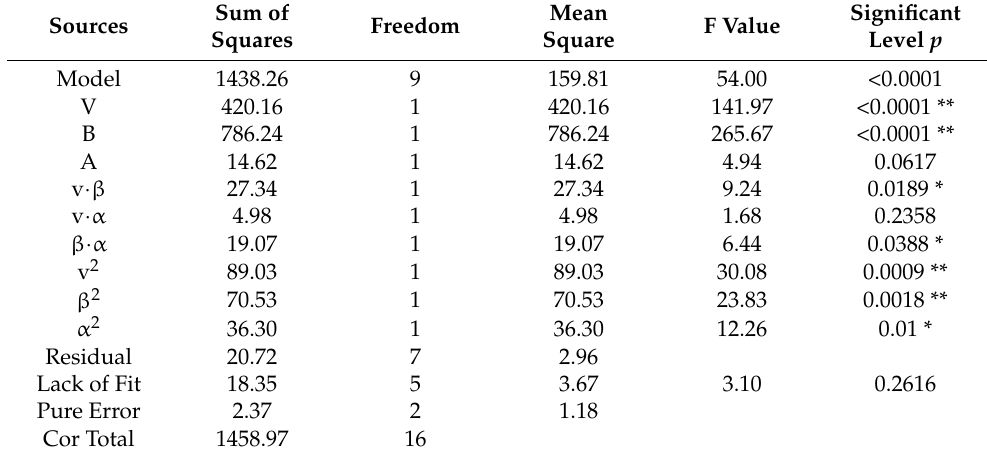
Table 5. Regression Equation